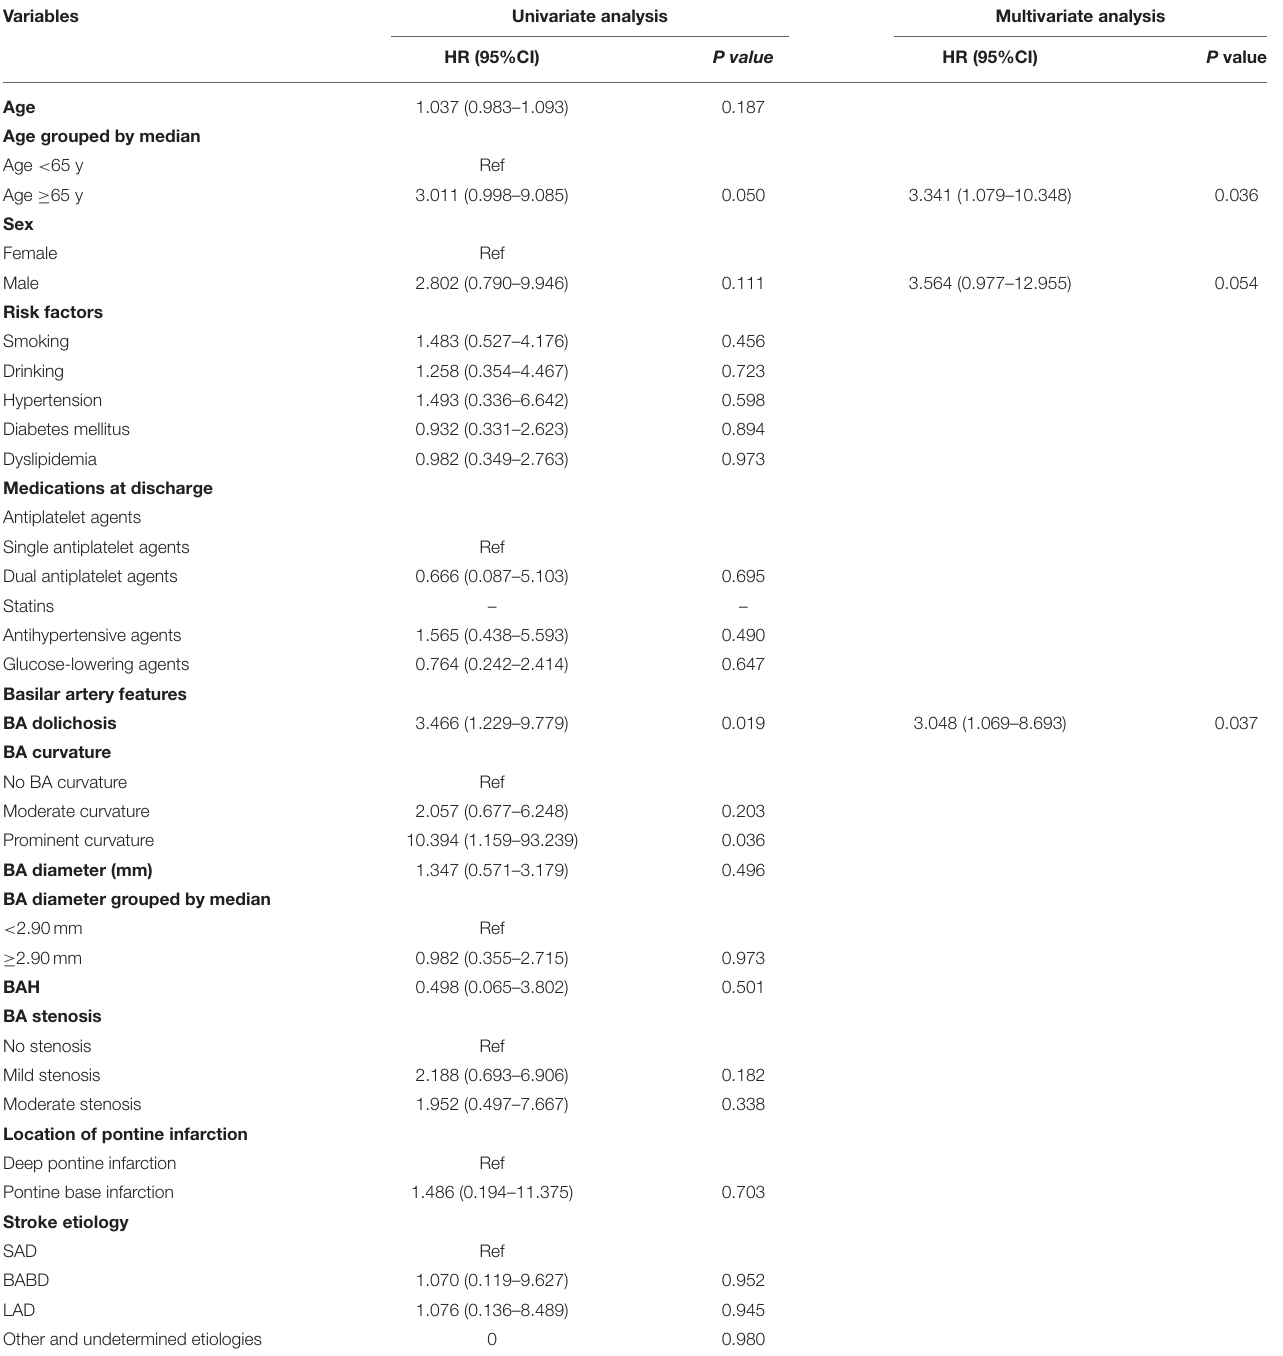
TABLE 2 | Univariate and multivariate Cox proportional-hazards models for the risk of brainstem infarction recurrence. Variables Univariate